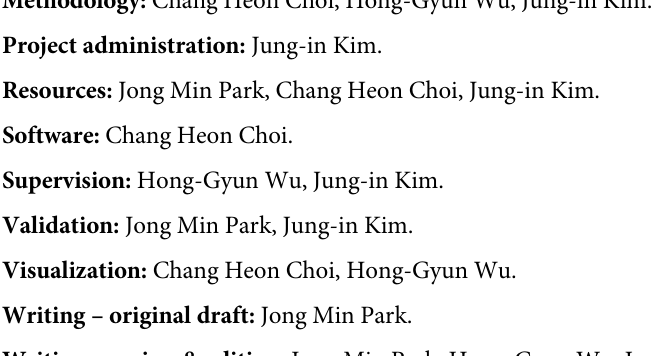
S1 Table. Average values and corresponding standard deviations of each dose-volumetric parameter error in the present study. S2 Table. Every Spearman’s correlation coefficient examined in the present study between the dose-volumetric parameter errors and gamma passing